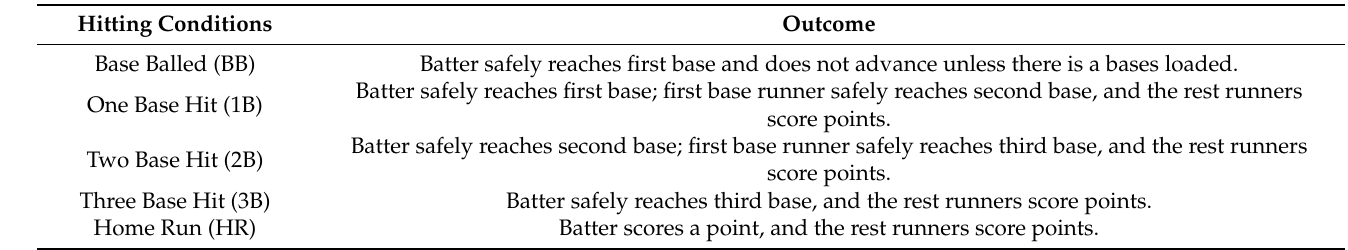
Table 2. Runner advancement model of D’Esopo and Lefkowitz. Outcome Batter safely reaches first base and does not advance unless there is a bases loaded. Batter safely reaches first base; first base runner safely reaches second base, and the rest runners score points. Batter safely reaches second base; first base runner safely reaches third base, and the rest runners score points. Batter safely reaches third base, and the rest runners score points. Batter scores a point, and the rest runners score